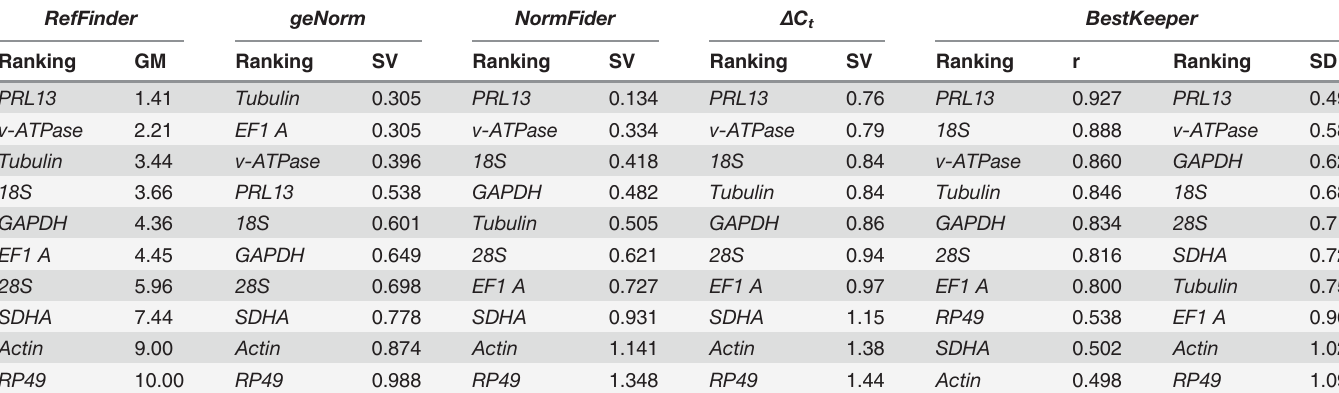
Table 2. A comprehensive ranking of the candidate reference genes using different algorithms * .